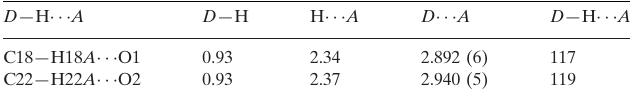
Hydrogen-bond geometry (A˚ , (cid:2)